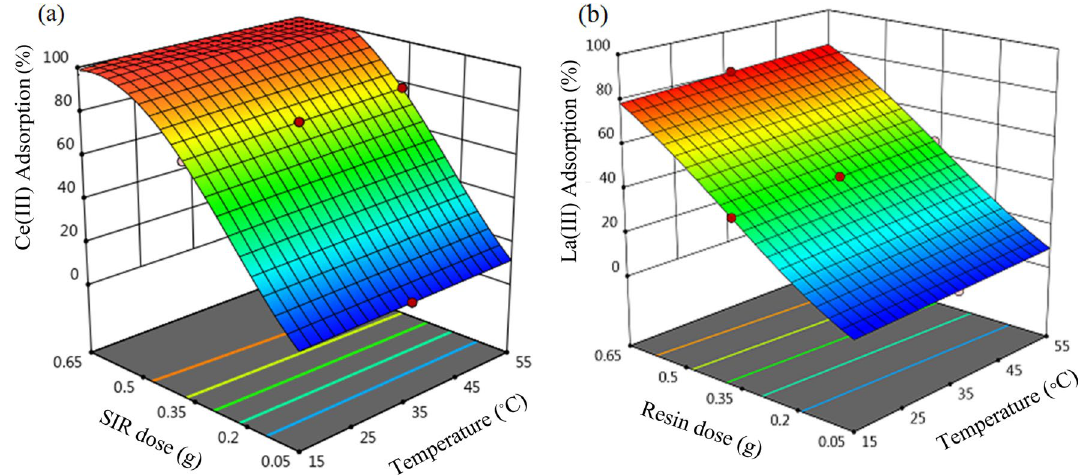
Figure 7. 3D sketches of the combined impact of temperature and SIR dose on the percentage adsorption of ( a ) Ce(III) and ( b ) La(III) (primary metal ions concentration 200 mg L −1 , pH = 4 and time 180